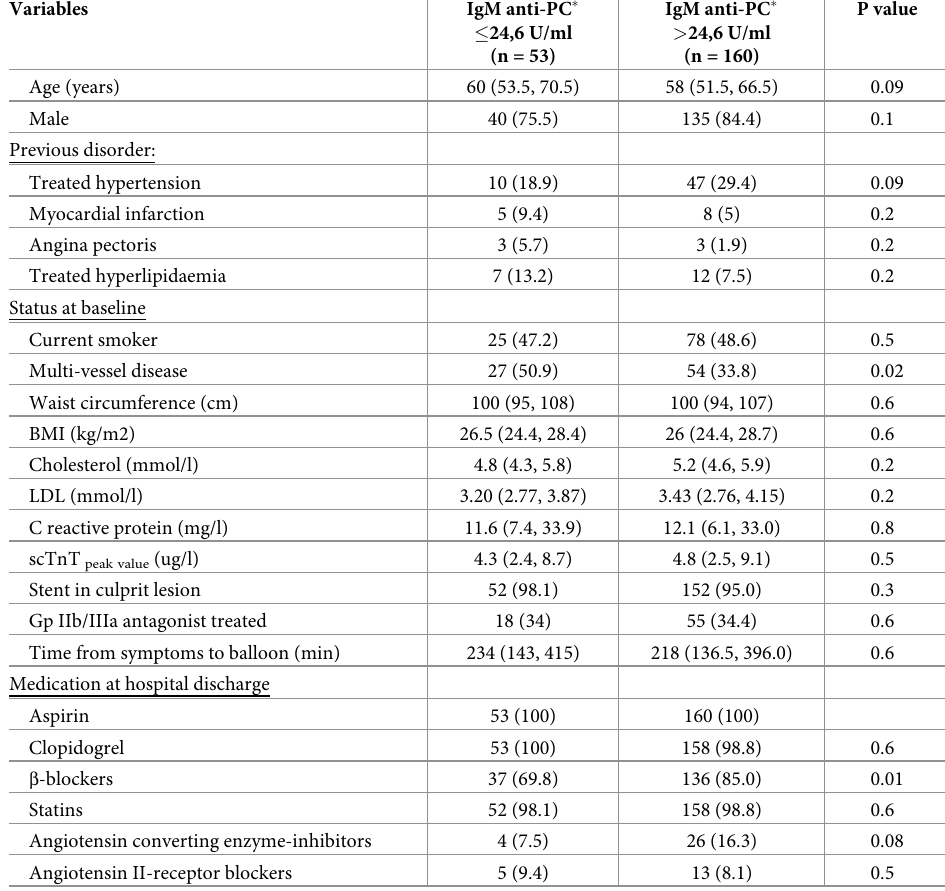
Table 1. Clinical characteristics related to IgM anti-PC levels measured in-hospital. Variables